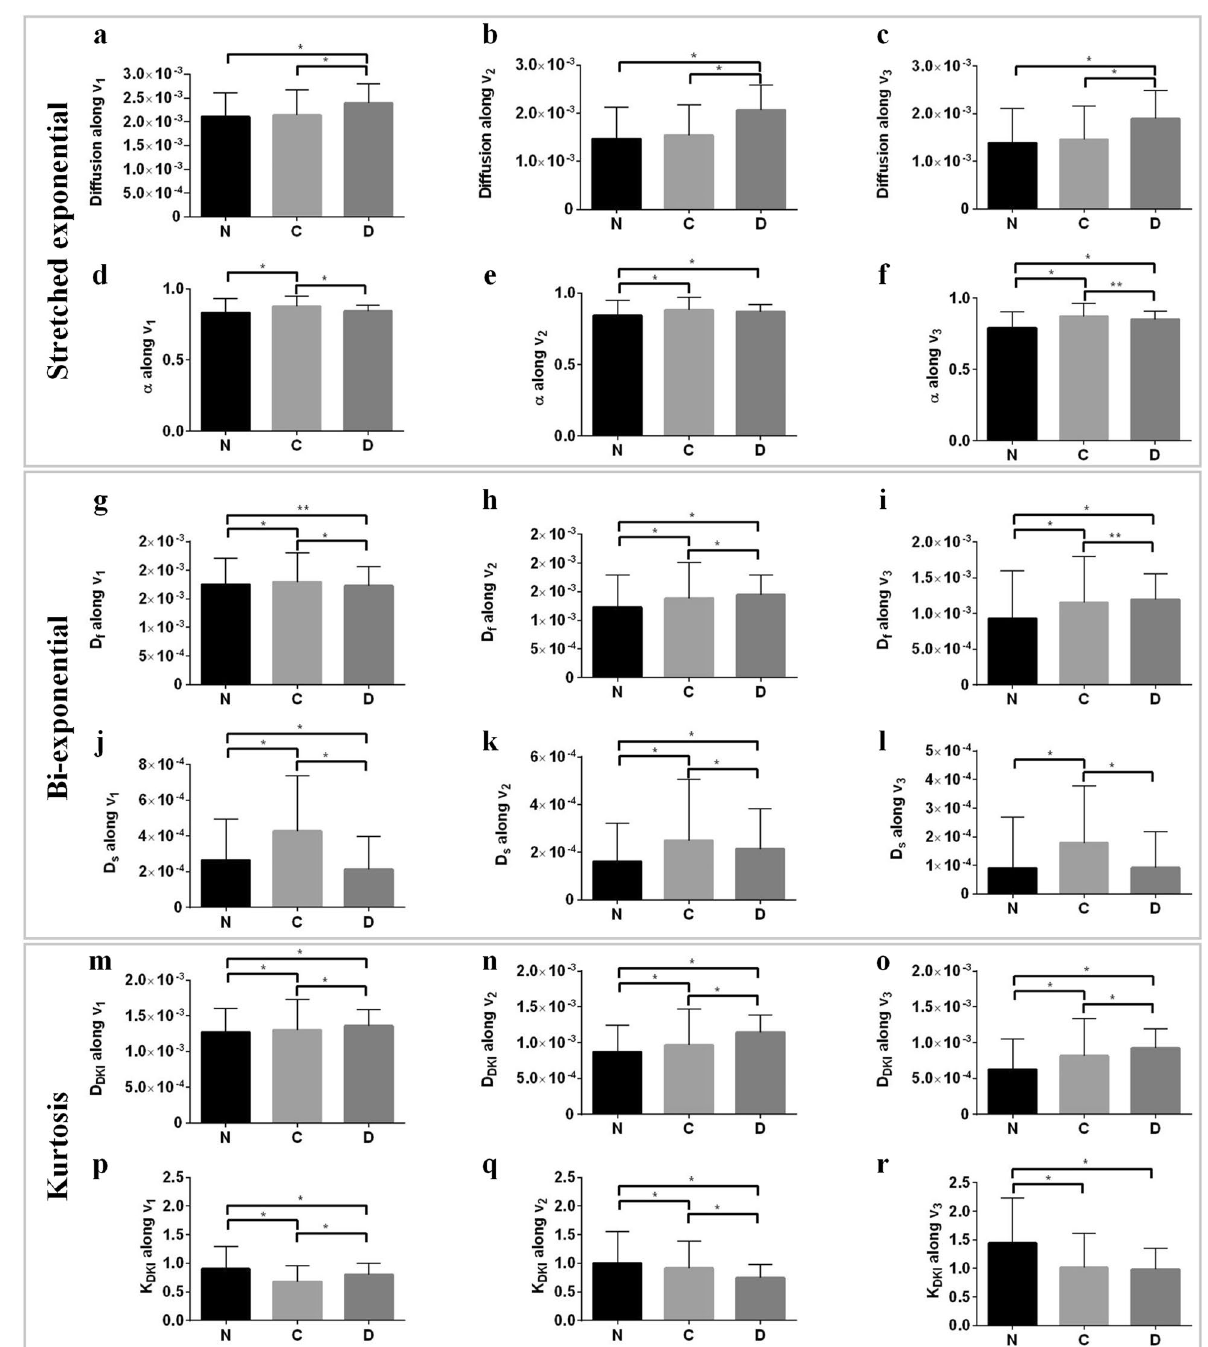
Figure 5. Quantification of tissue heterogeneity using non-Gaussian based parameters using HMb protocol. The derived indices are displayed as columns (mean) for each ROI. Three native tissue (N) samples, three collagenases treated tissue (C) samples and three decellularized tissue (D) samples were used for comparison. (n = 12, one ROI per slice, 4 slices per sample). ( a – f ) Stretched exponential, ( g – l ) Bi-exponential and ( m - r ) Kurtosis. Values represent mean ± SD. * p < 0.01; ** p <